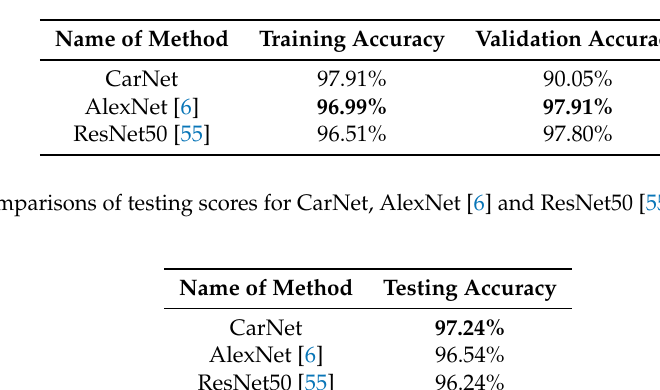
Table 11. Comparisons of training and validation accuracies for CarNet, AlexNet [6] and ResNet50 [55] on CNRPark + EXT dataset [5].